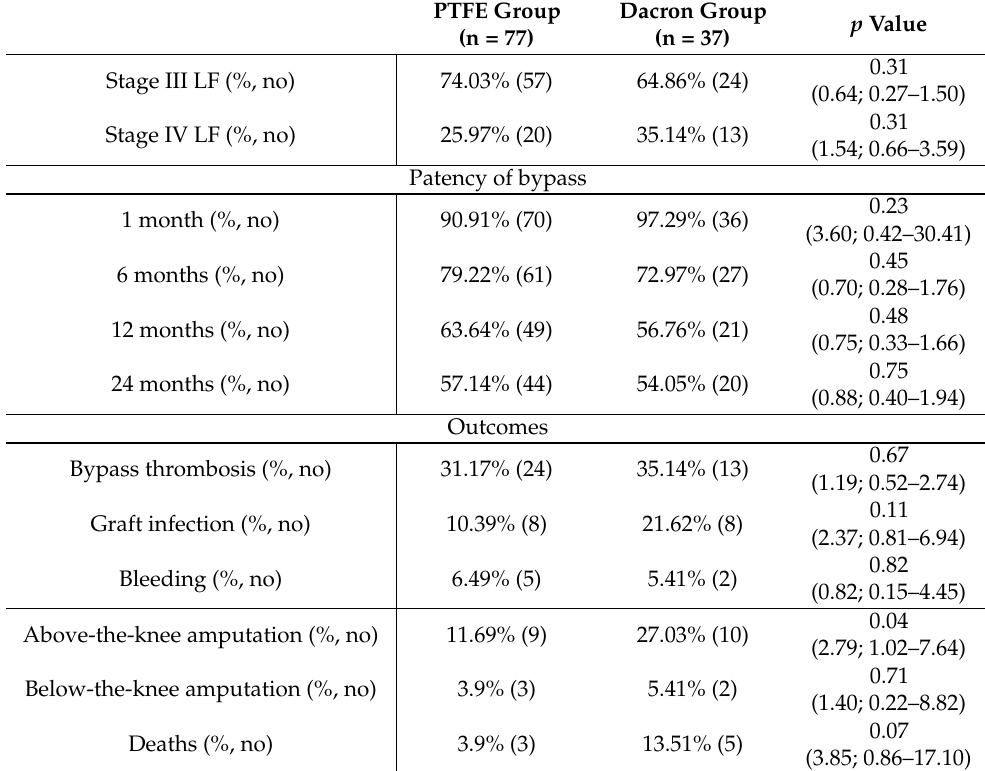
Table 4. Leriche–Fontaine classification, patency, complications, and outcomes of AK FP bypass patients.